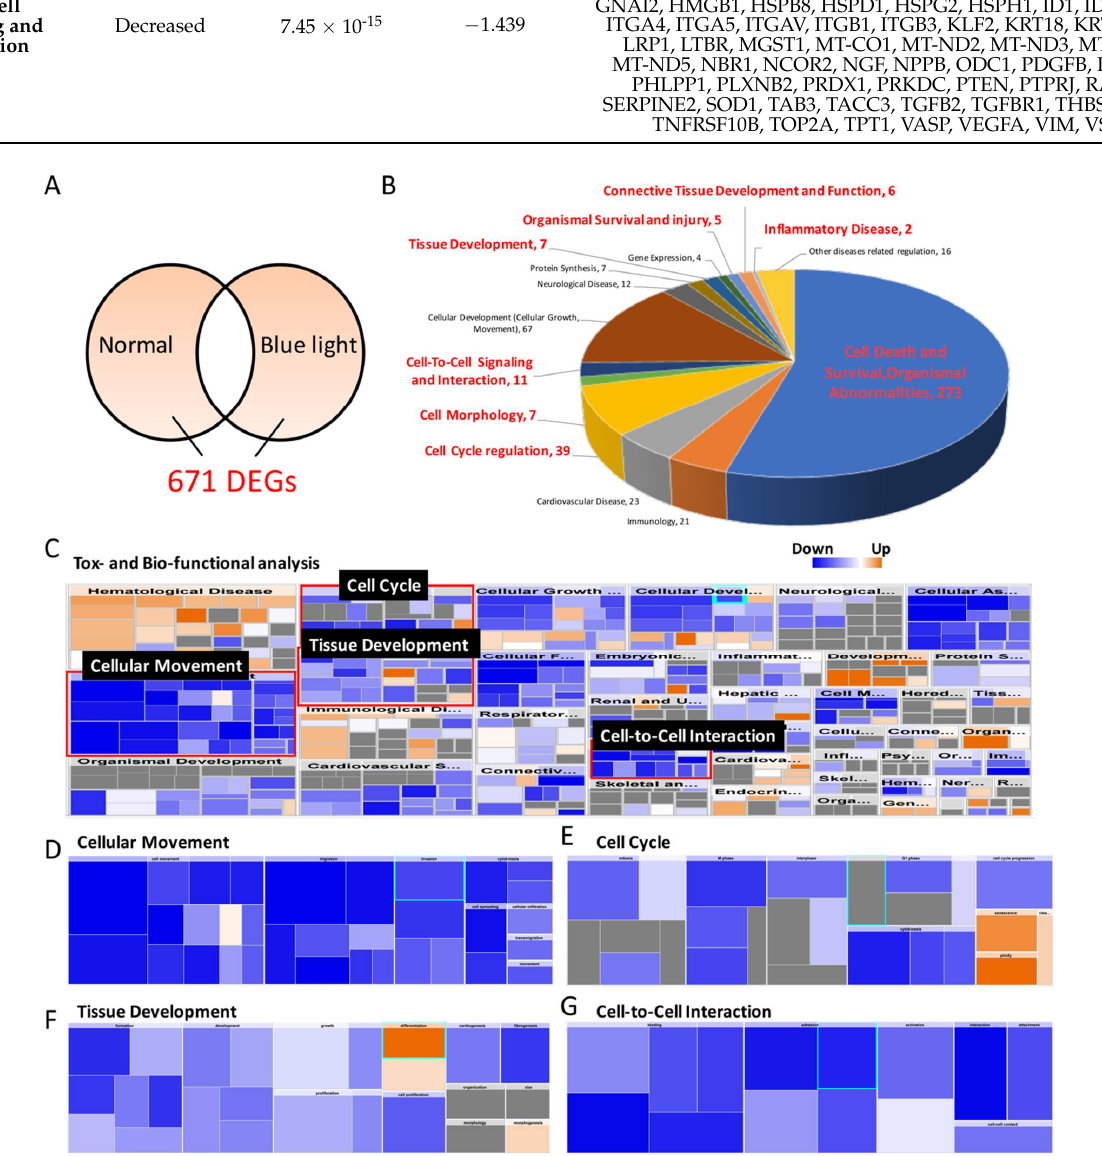
Figure 6. Differential gene expression analysis and the potential mechanisms in ARPE-19 cells regulated by blue light. ( A ) The total number of differentially expressed genes (DEGs) between the control and blue-light-exposed groups. ( B ) Top 15 cellular diseases and functions of the 671 DEGs involved. ( C ) General heatmap of the toxicity and biofunctional analysis generated by IPA and individual catalog heatmaps, including ( D ) cellular movement, ( E ) cell cycle, ( F ) tissue development, and ( G ) cell-to-cell signaling and interaction, were specifically analyzed to determine the regulation pathways affected by blue light. Blue: decreased gene expression; orange: increased gene expression.